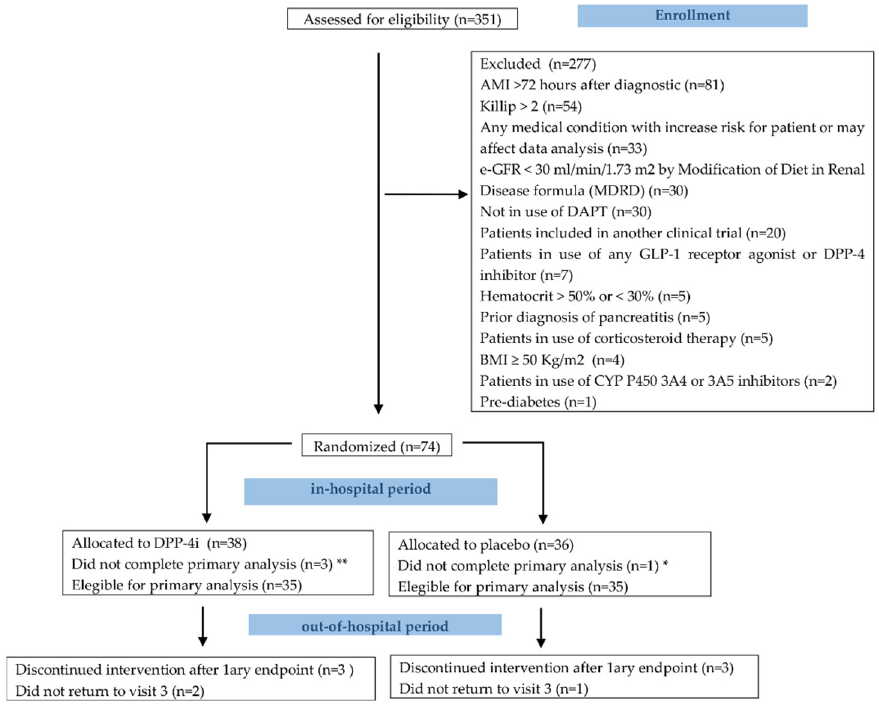
Figure 2. Study flowchart. Allocation (n): * screen failure (1). ** declined to participate—withdrawal informed consent (1); screen failure (2). Primary objective (n = 70). Discontinued intervention at visit 3: six pats (4) adverse event; (2) declined to participate—withdrawal informed consent. Did not return to visit 3: three patients (1) Serious adverse event. (1) Adverse event. (1) Declined to participate—withdrawal informed